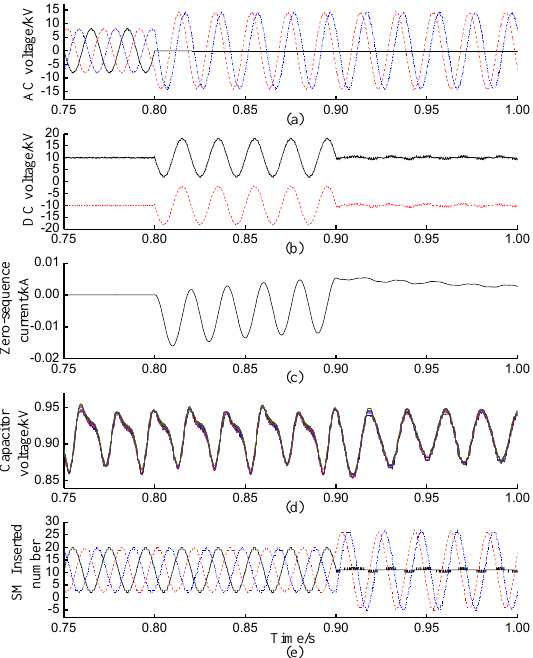
Figure 11. Fault response characteristics of MMC1 after optimization. ( a ) Three-phase AC voltage (black is A-phase, red is B-phase, blue is C-phase). ( b ) Positive and negative DC voltage (black is positive DC voltage, red is negative DC voltage). ( c ) AC zero-sequence current. ( d ) SM capacitor voltage. ( e ) Inserted SM number of the upper arm on the MMC1 (black is A-phase, red is B-phase, blue is C-phase).